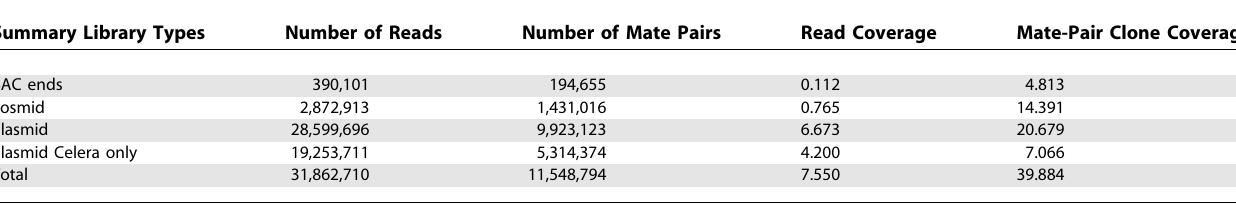
Table 1. Clone Insert Library Types and Reads Used for HuRef Genome Assembly Summary Library